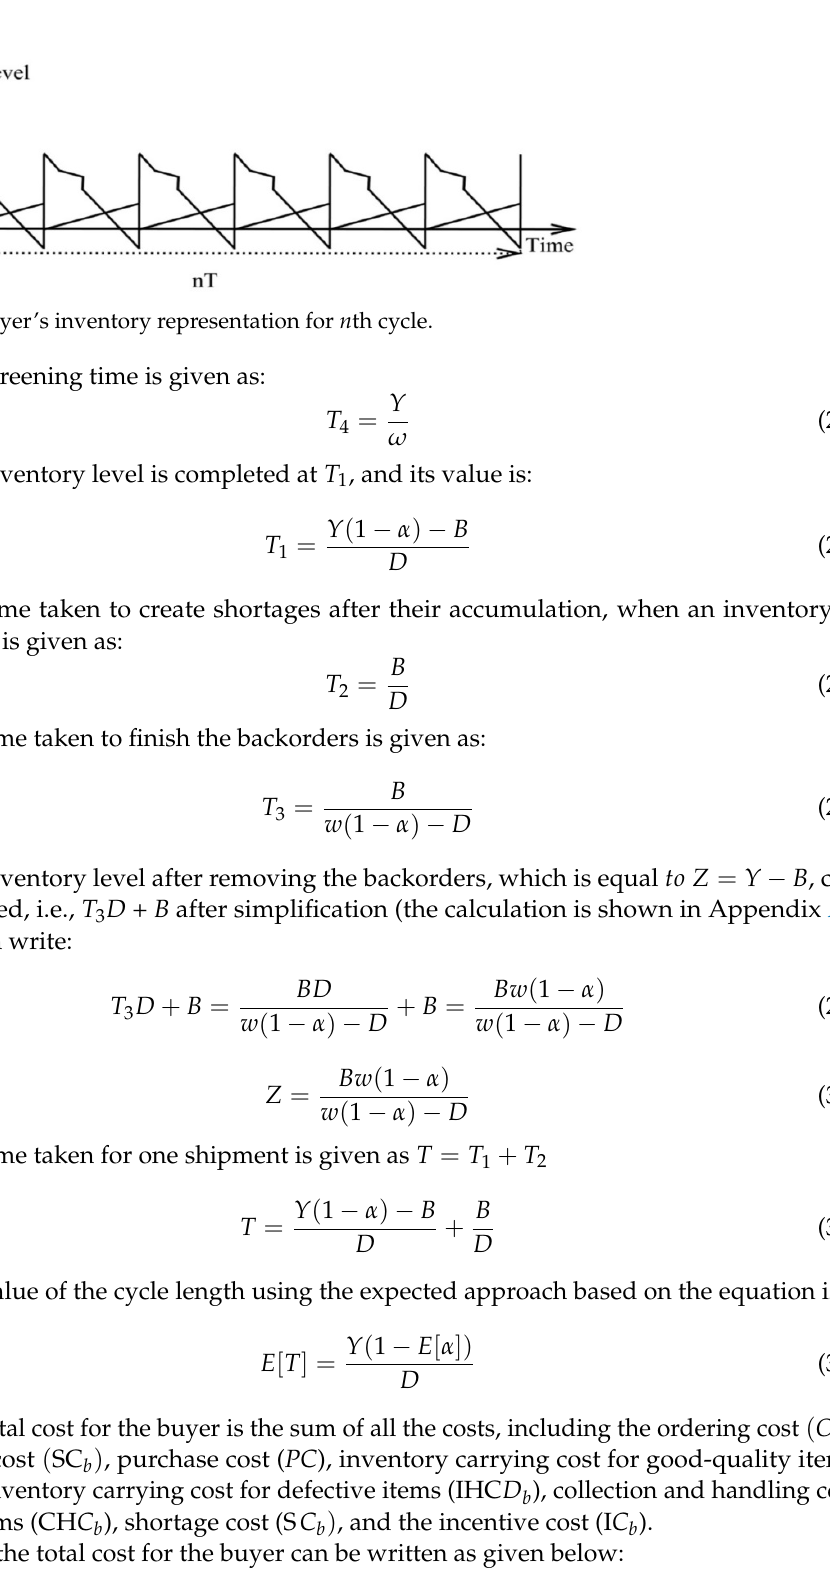
Figure 7. Buyer’s inventory representation for time 𝑇 .